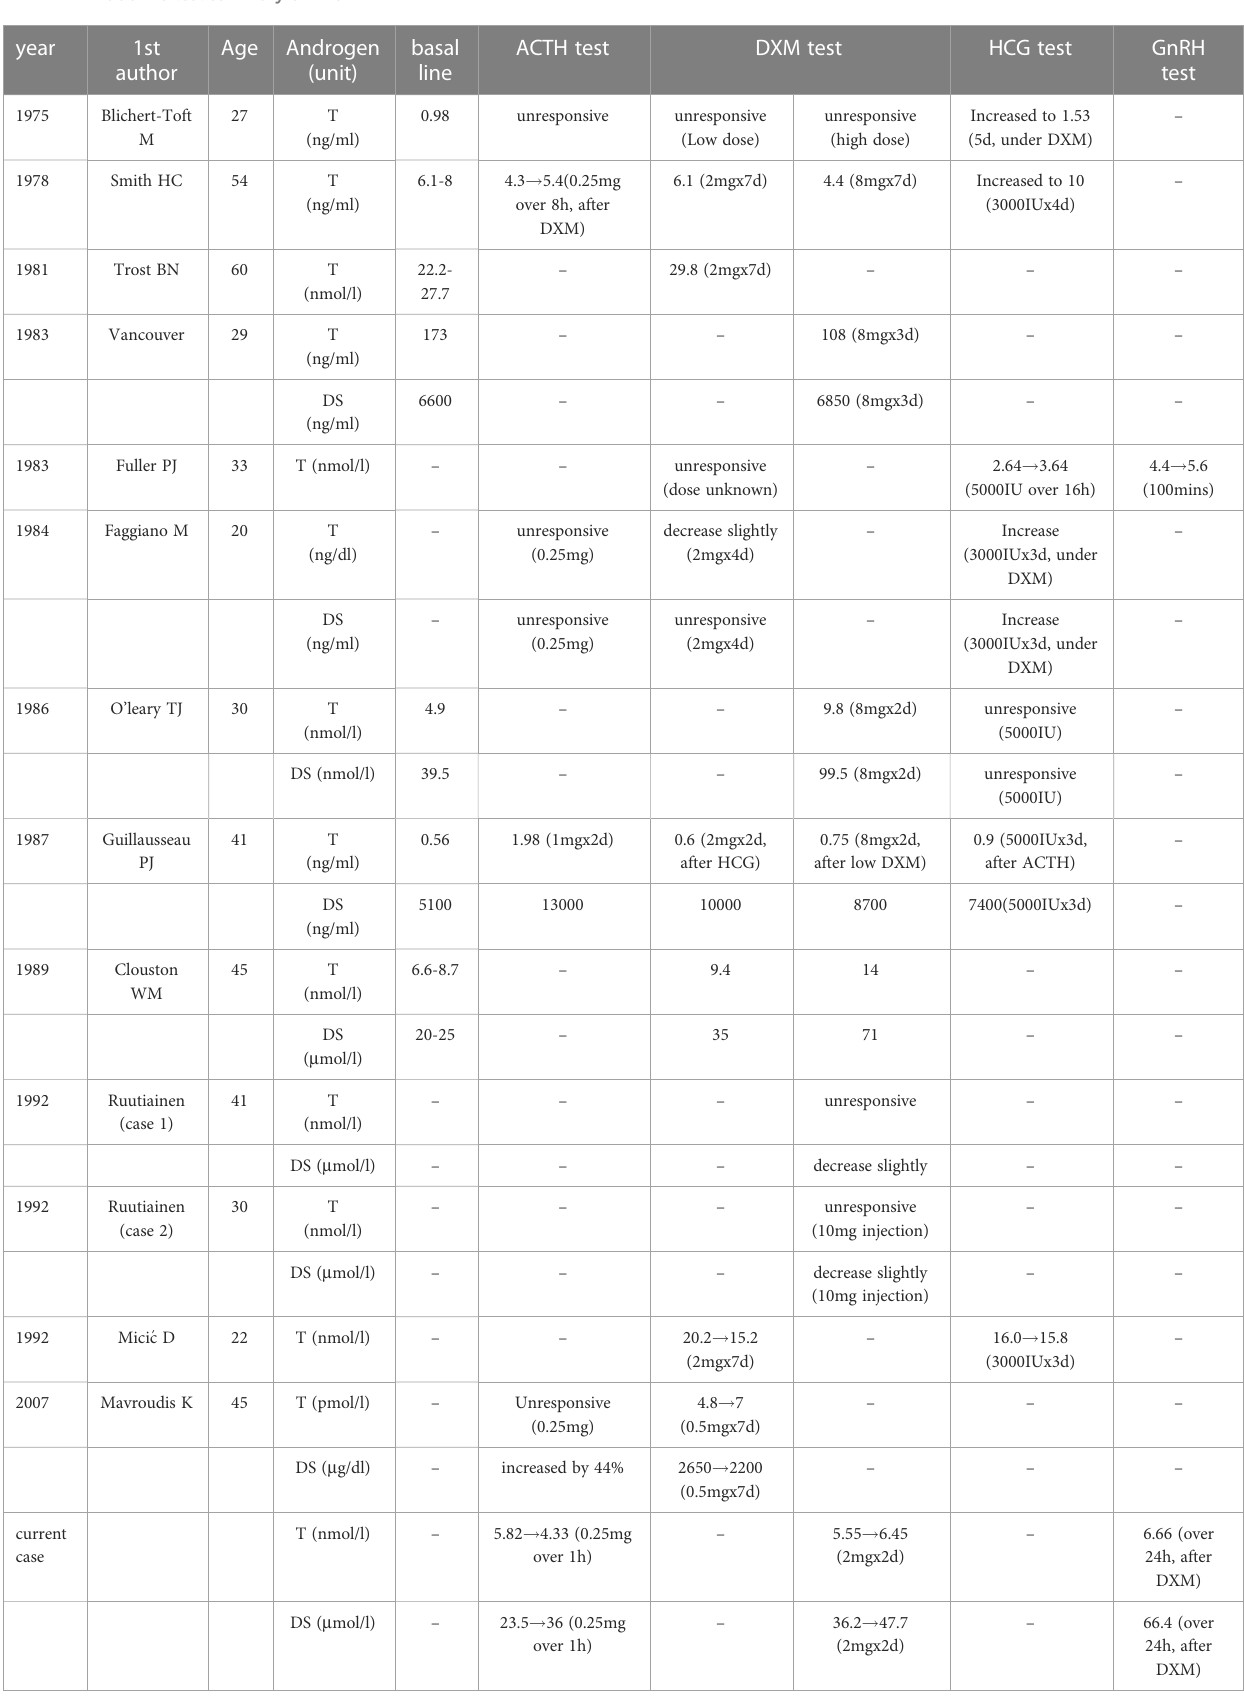
TABLE 4 Endocrine test summary of